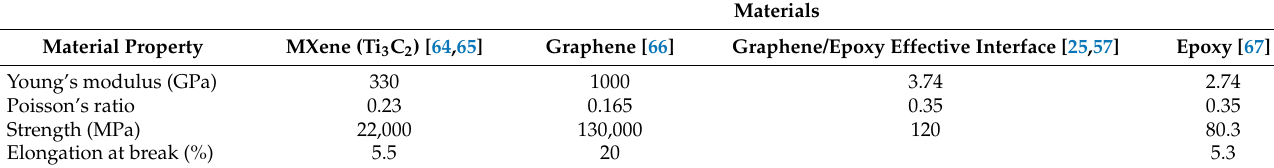
Table 1. The mechanical properties of the